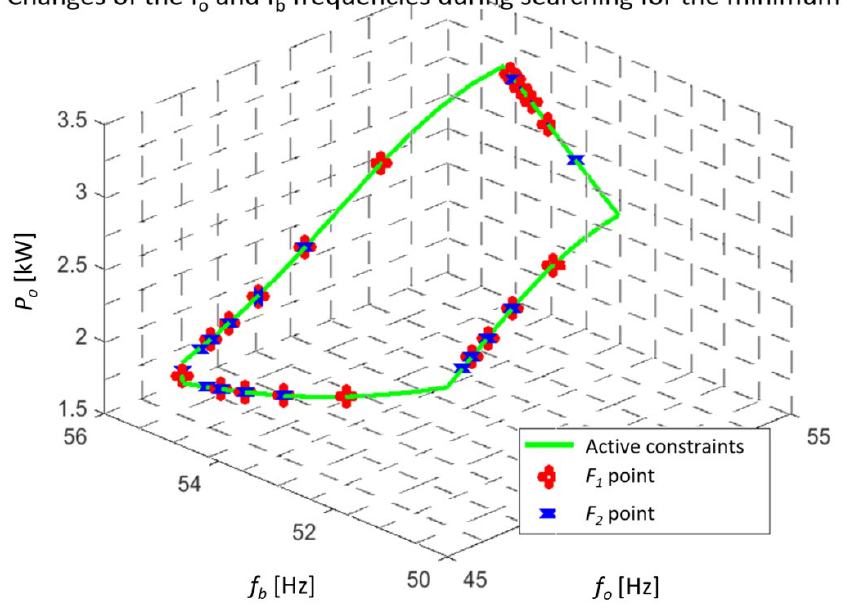
Figure 12. Simulation of searching for the minimum active power by directional optimization on active the active constraints.